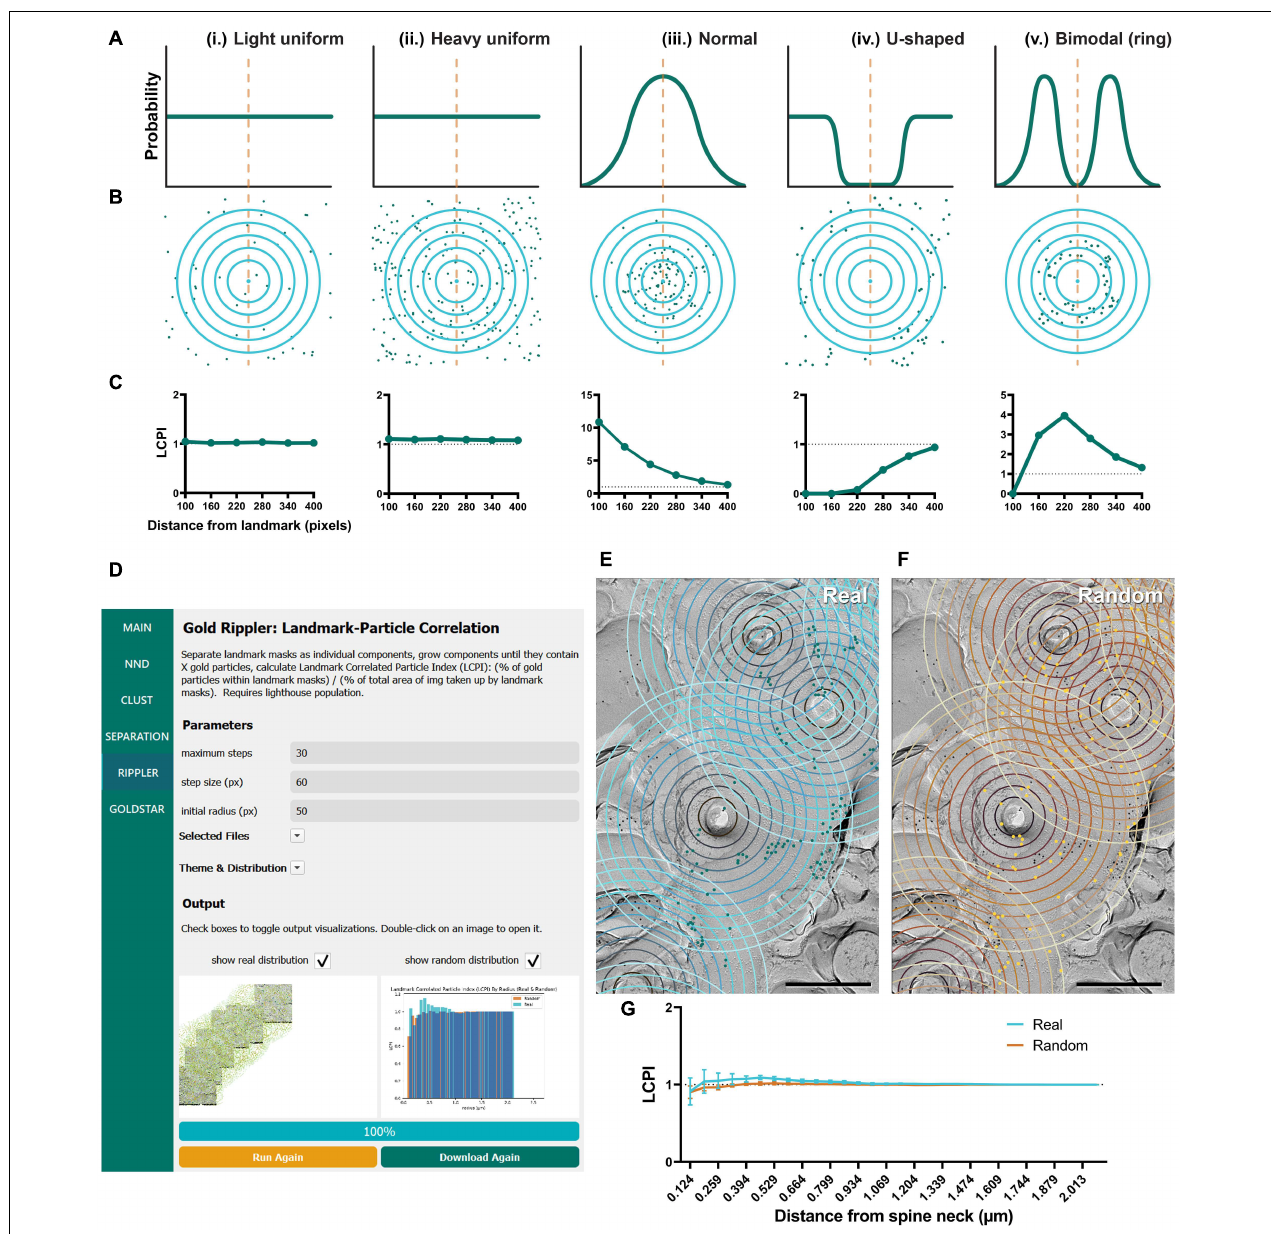
FIGURE 6 | Modeling and application of the Gold Rippler workflow, used for analysis of particle bias toward or away from a landmark feature (e.g., dendritic spines). (A) Several theoretical probability distributions that particles may have relative to a landmark feature, and (B) a simulation of particle positions using those probability distributions. The orange dashed line indicates the position of the landmark, and blue concentric circles (ripples) radiating outwards indicate binned distances from the landmark. Particles are shown as green dots. (i) Light uniform random and (ii) heavy uniform random distributions of particle positions are examples of zero-bias distributions. (iii) Normal, (iv) U-shaped, and (v) Bimodal distributions of particle positions show some bias relative to the landmark feature. (C) Simulated LCPI curves for each distribution (average of 100 iterations). Light and heavy uniform random particle distributions both exhibit a constant LCPI of one regardless of distance from the landmark. A normal distribution of particles around a landmark can be expected to produce an LCPI curve that begins at a high value, then slowly decreases to approach one. A U-shaped distribution can be expected to produce a curve that starts near zero and increases to approach one. A bimodal or ring distribution can be expected to start at or below one, increase past it, then decrease again to approach one. Gray dotted lines indicate an LCPI of one. Random distributions can be expected to match the uniform random distributions shown by (i, ii). (D) GIO interface showing the Gold Rippler workflow. Parameters show additional fields for setting the maximum number of steps (ripples), and the step size (distance between ripples) in pixels. A labeled image of the ROI is displayed along with a histogram of the LCPI for real and/or random distributions. (E) The Gold Rippler output of a portion of the Purkinje cell dendrite ROI image shown in Figure 5A . Dendritic spine neck cross-fracture is used as the landmark feature, and several blue concentric “ripples” radiate from each. (F) The Gold Rippler output for a random distribution of particles (yellow) superimposed on the same ROI. (G) The LCPI curve for real and random particle distributions using dendritic spine neck cross-fracture as landmark features. Dots and error bars represent mean ± S.E.M. Dotted line indicates an LCPI of one. n = 11 ROIs. Scale bars: 500 nm.